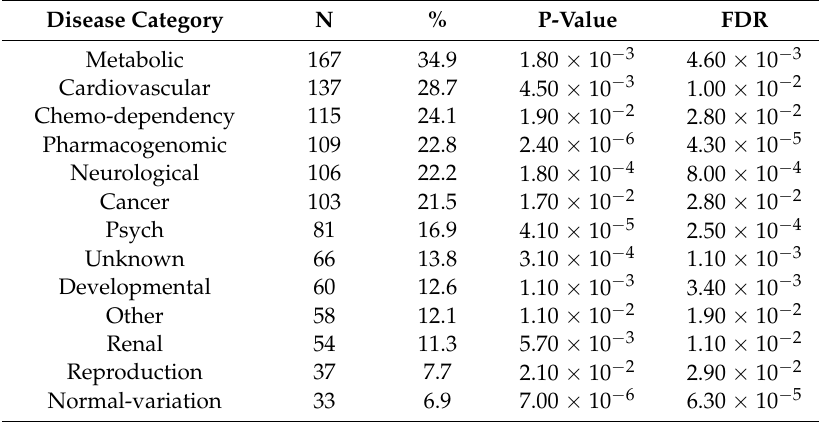
Table 3. The list of 13 group of diseases targeted by the enrichment analysis (DAVID 6.7). The analysis includes two tests to assess significance of the genes participating to each disease category (Permutation test P-value and FDR correction). N = number of genes with implication in the categorized disease. % = percentage of representation in the total of 429